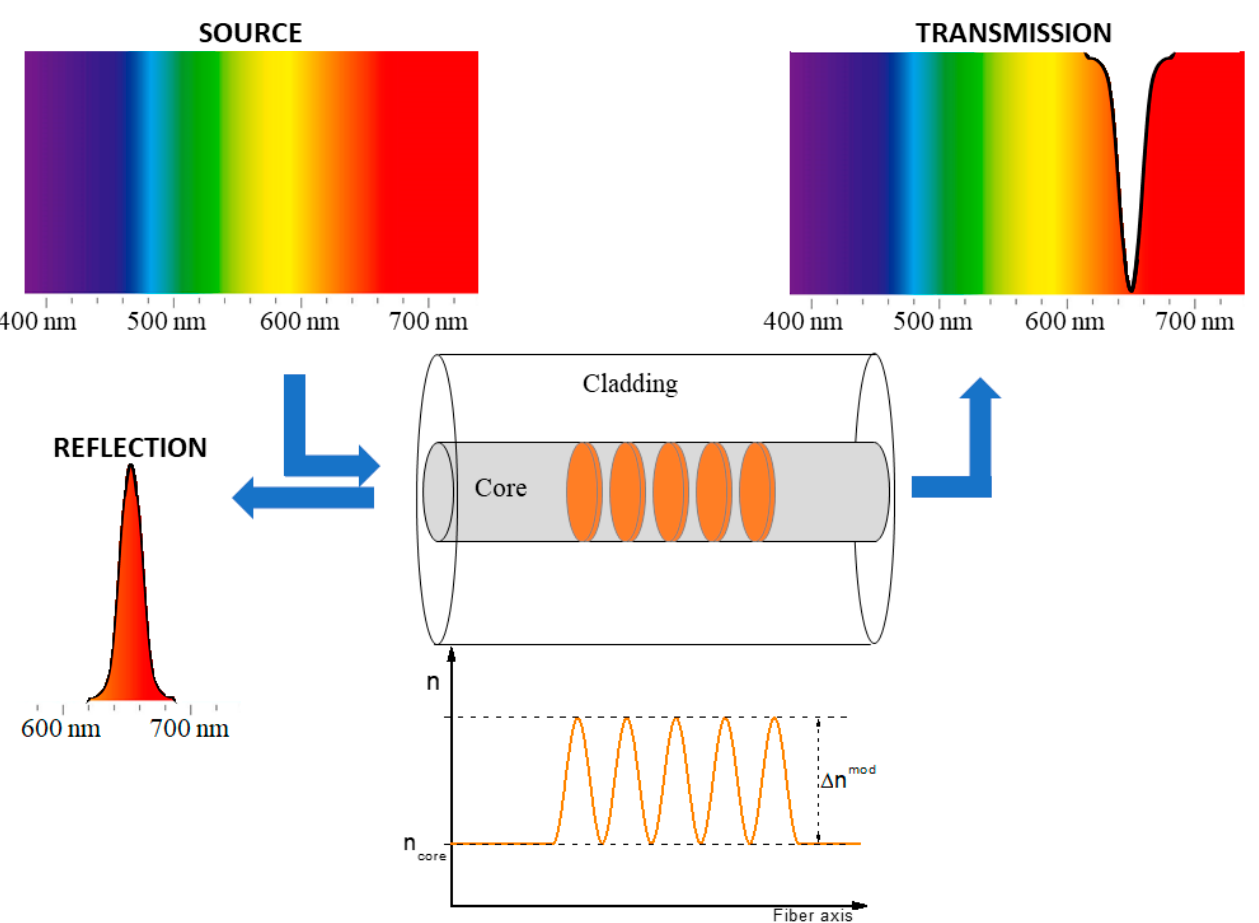
Figure 1. Transmission and reflection spectra of a fiber Bragg grating, with the periodical structure of the refractive index in the fiber core.